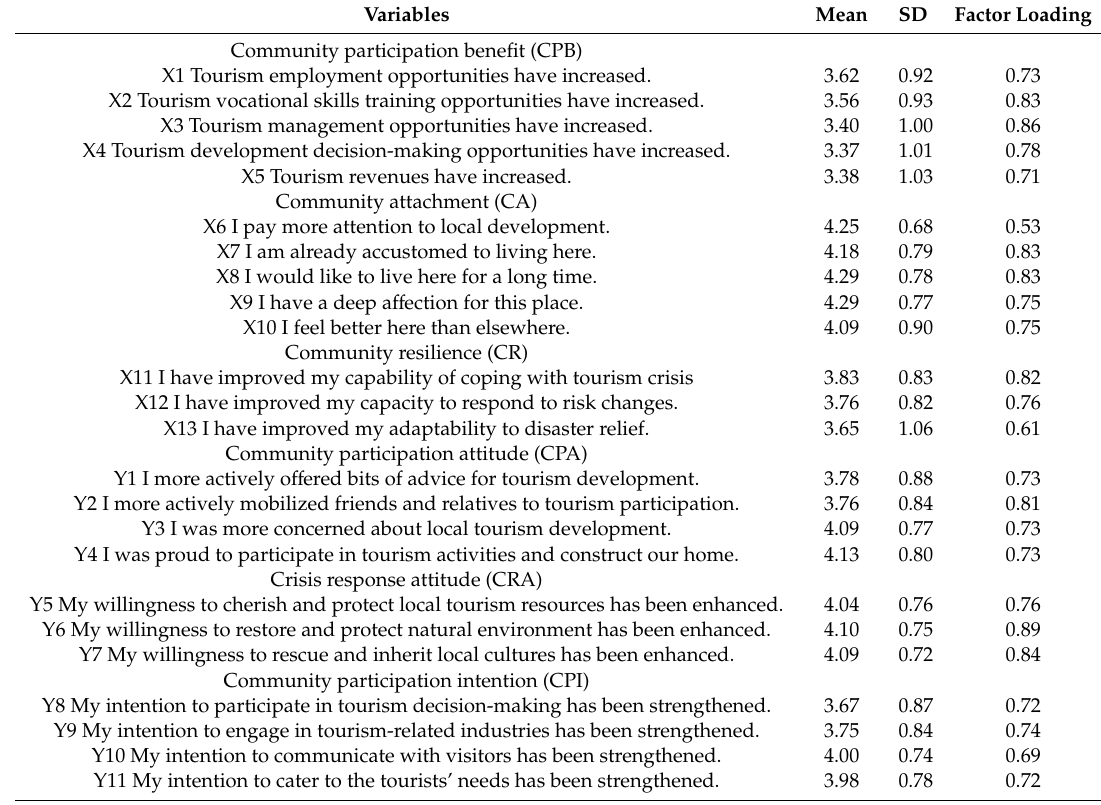
Table 4. Construct dimensions and